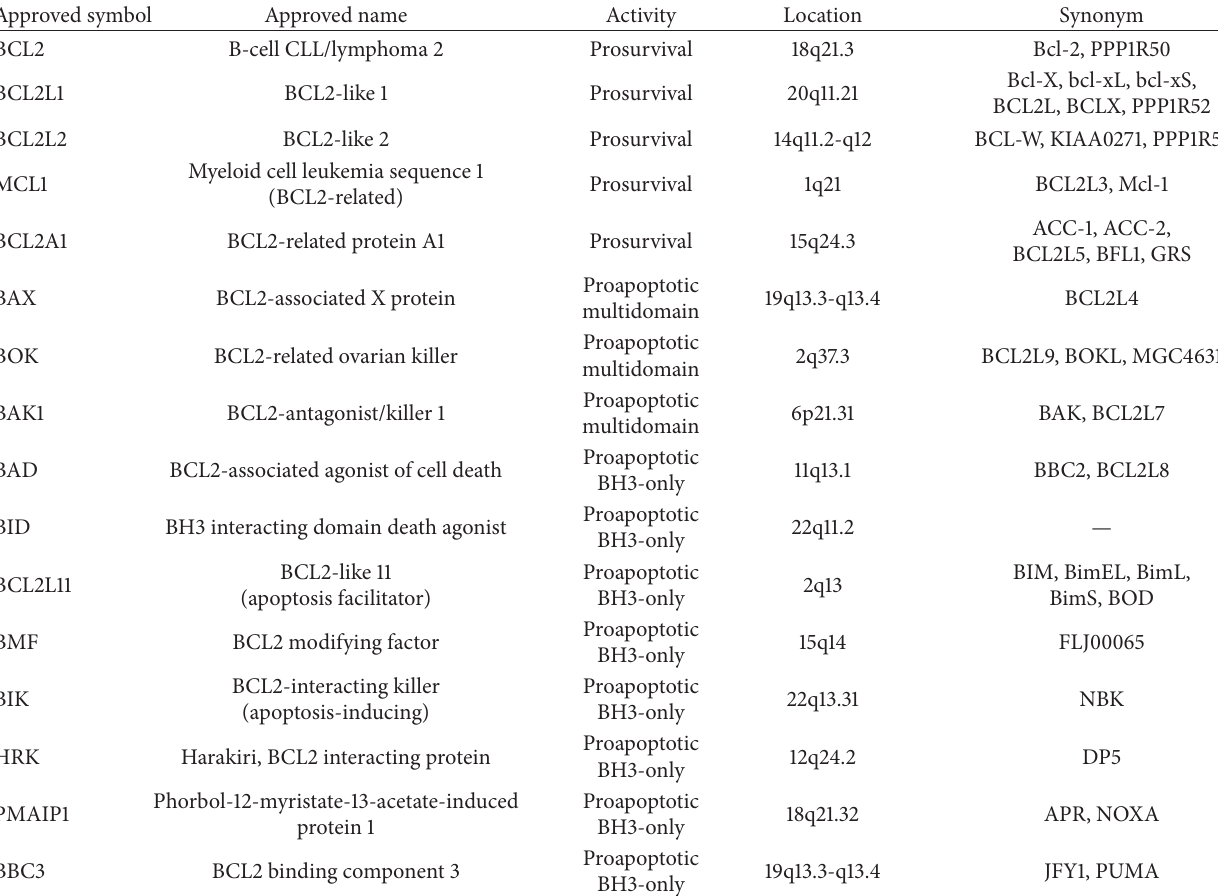
Table 1: Approved Hugo gene nomenclature of the BCL2